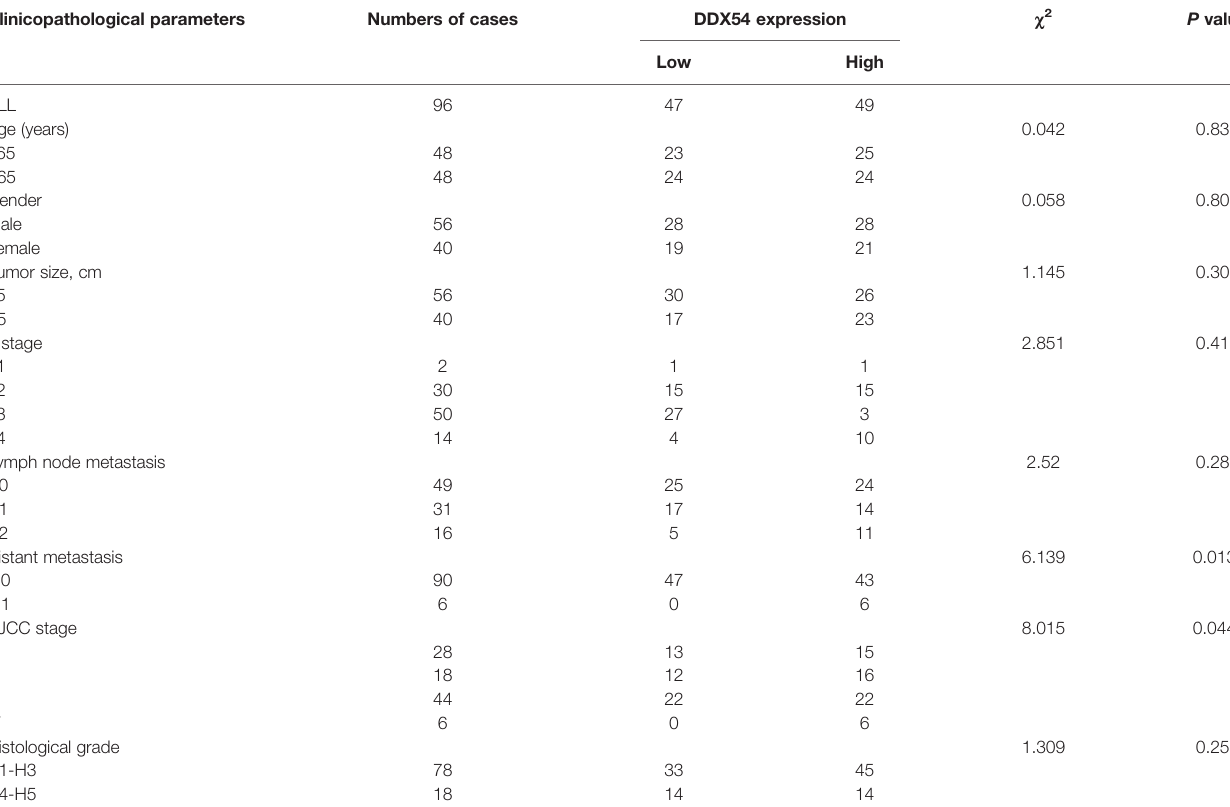
TABLE 1 | Association between DDX54 expression and clinicopathological features of patients with colorectal cancer. Clinicopathological